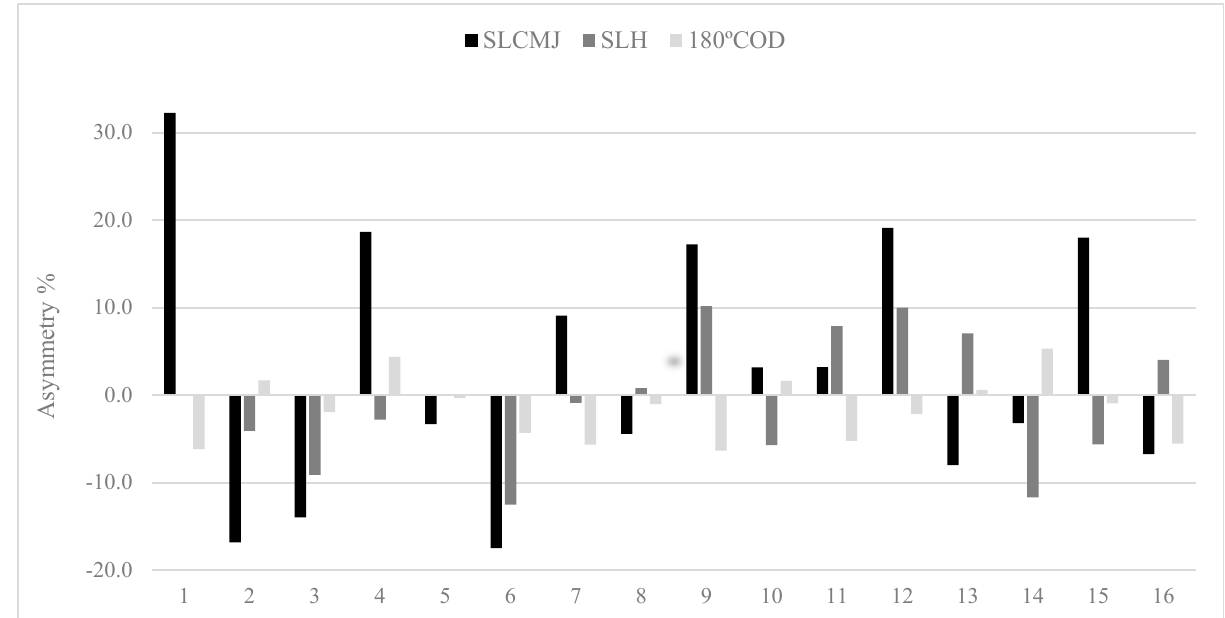
Figure 1. Data about individual asymmetry for single leg countermovement jump (SLCMJ), single leg hop (SLH) and 180° change of direction (180° COD) in the U-14 group. N.B: above 0 indicates right leg dominance and below 0 indicates left leg dominance.